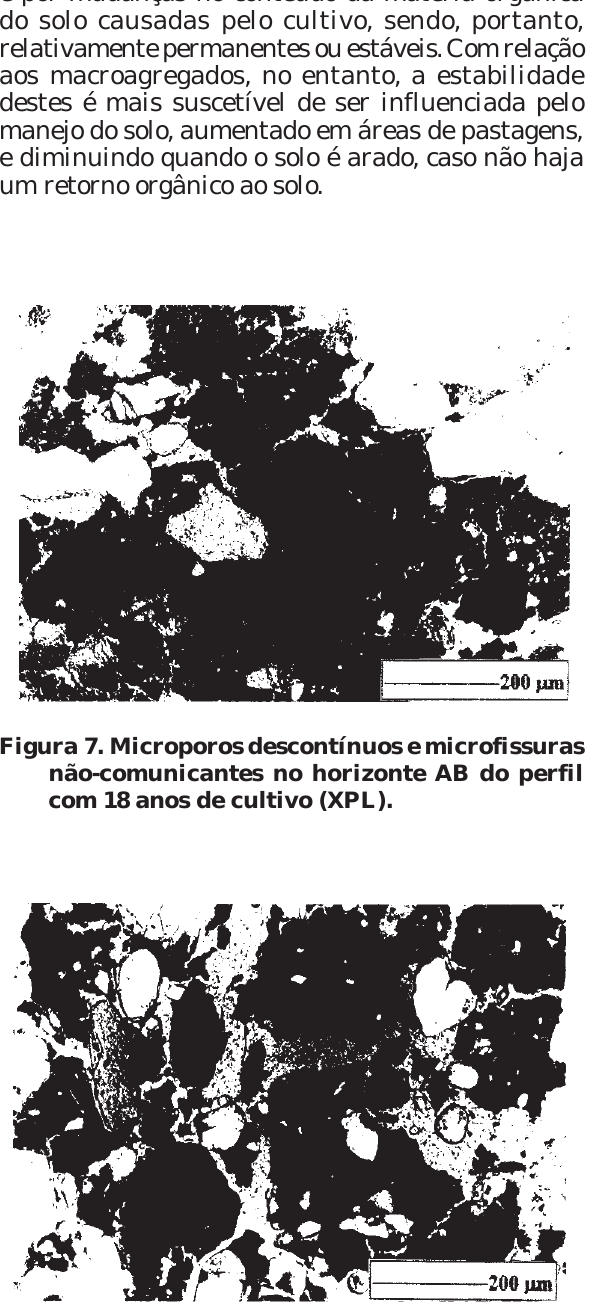
Figura 8. Microfissuras não-comunicantes no horizonte AB do perfil com 25 anos de cultivo